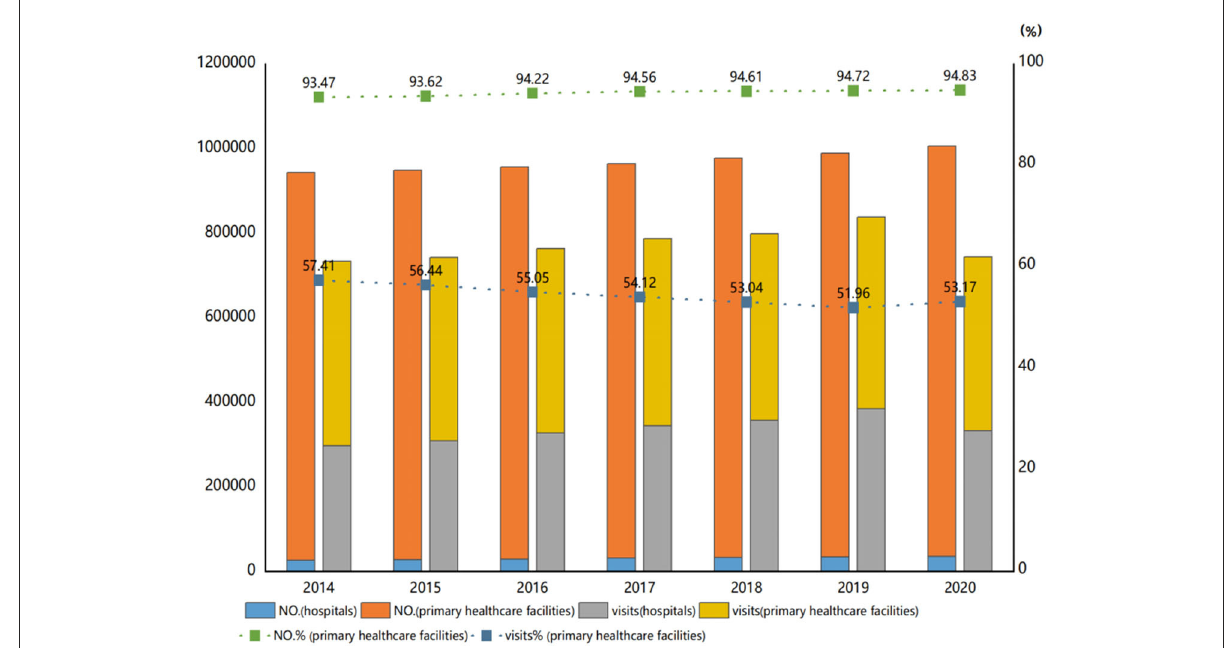
FIGURE1 The number of medical institutions and the number of visits in China from 2014 to